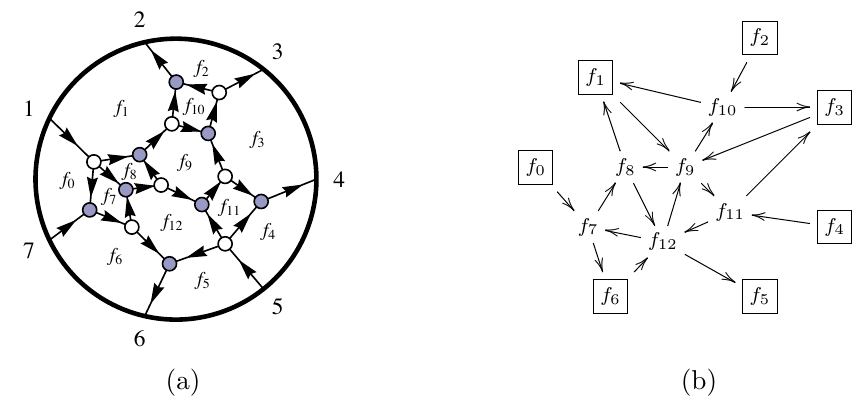
Figure 1 . (a) A plabic graph corresponding to the top cell of G + (3 , 7) and (b) the associated dual quiver, associated to a cluster of the G(3 , 7) cluster